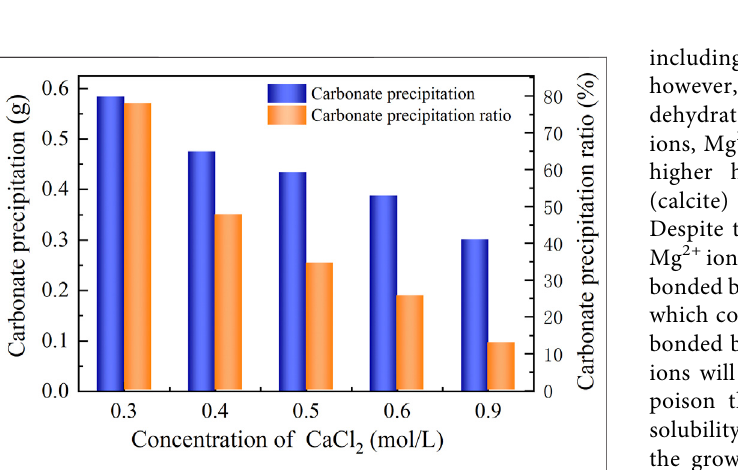
FIGURE 8 | Temporal relations of EC and pH when subjected to the effect of CaCl 2 addition: (A) EC and (B) pH.